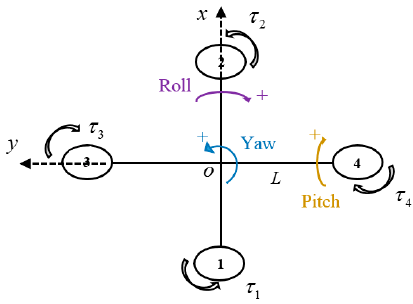
Figure 1. Schematic of the geometric configuration of the quadcopter unmanned aerial vehicle (UAV).